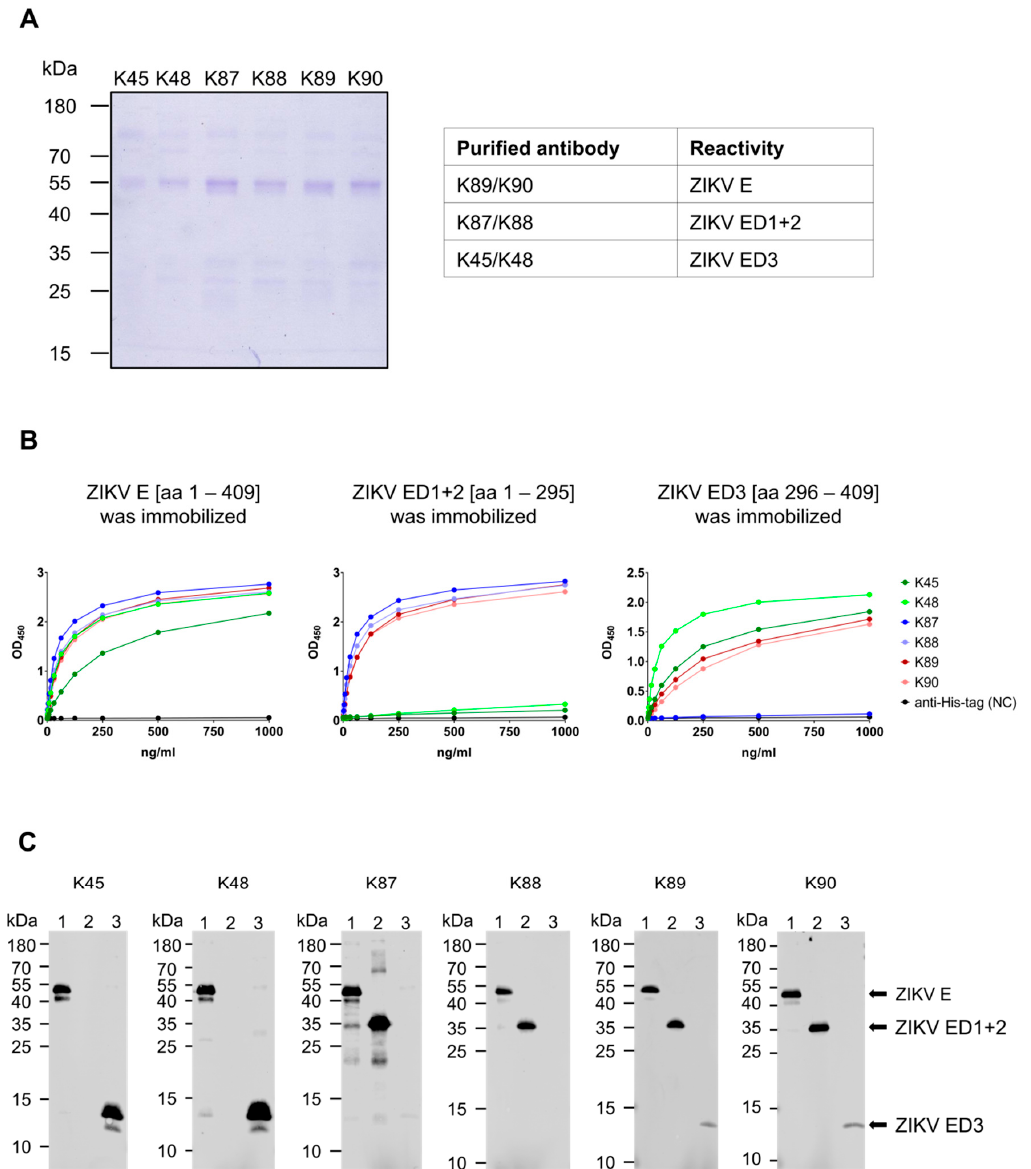
Figure 3. Purification of the ZIKV E domain-specific antibodies. ( A ) Coomassie staining of SDS-gel loaded with the purified antibodies; ( B ) Binding capacity of the purified antibodies to the different ZIKV E domains demonstrated by ELISA. ELISA plates were coated with the strep-tagged-ZIKV E domain proteins and serial dilutions of the purified antibodies were applied. Rabbit-derived His-tag-specific antibody was applied as negative control. The ELISA results represent one of two independent experiments; ( C ) Western blot analysis of SDS-gels loaded with the strep-tagged ZIKV envelope proteins: (1) ZIKV E, (2) ZIKV ED1+2, and (3) ZIKV ED3. The theoretical molecular weights of the purified proteins are: 46, 34, and 14 kDa, respectively. Each of the rabbit purified antibodies (K45–K90, 0.5 µg/mL) was used separately as a primary antibody. As secondary antibody, anti-rabbit was applied.